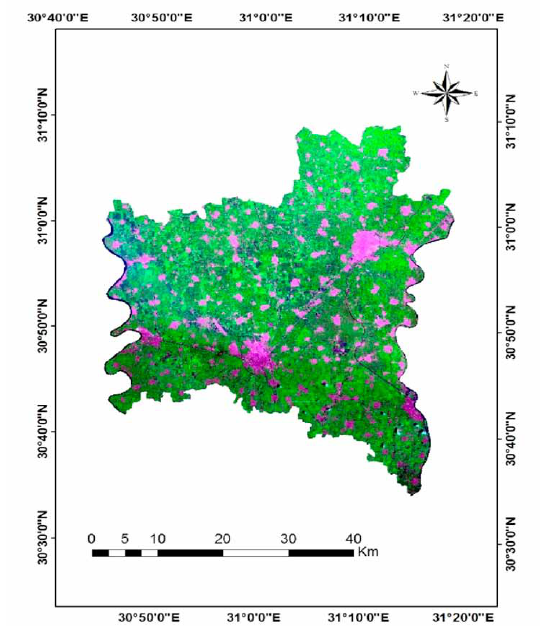
Fig. 2. Landsat 8 mosaic of the study